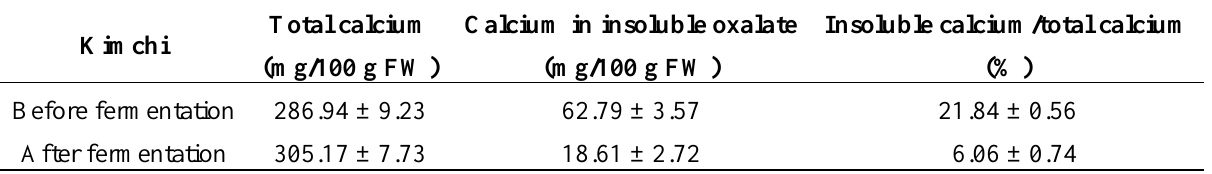
Table 5. Mean total calcium, calculated calcium bound in insoluble oxalate and % bound calcium in kimchi before and after fermentation (mg/100 g